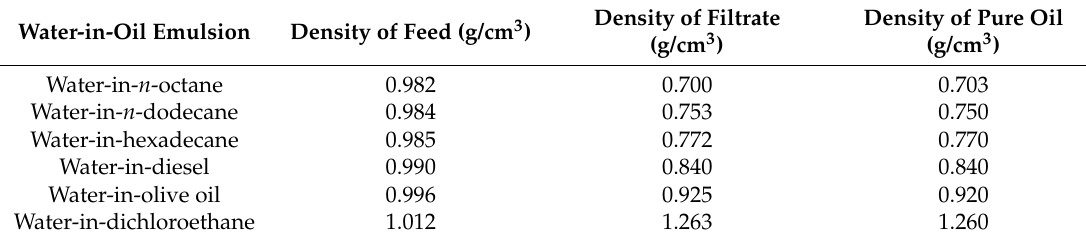
Figure 6. The water droplet size distribution of ( a ) stabilized water-in-olive oil emulsion; ( b ) stabilized water-in-diesel emulsion; and ( c ) stabilized water-in-hexadecane emulsion before and after separation. ( d ) Summary of the separating fluxes of three kinds of emulsions. Table 1. Densities of feed, filter, and pure oil.